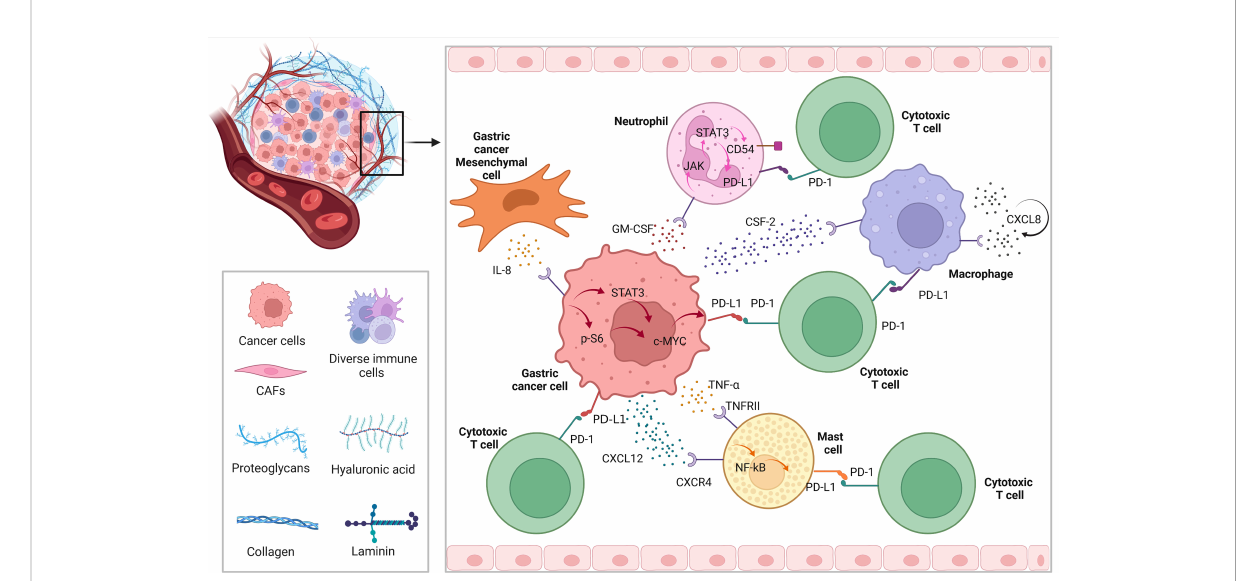
FIGURE 2 The regulatory mechanism of PD-L1 expression among tumor microenvironment in